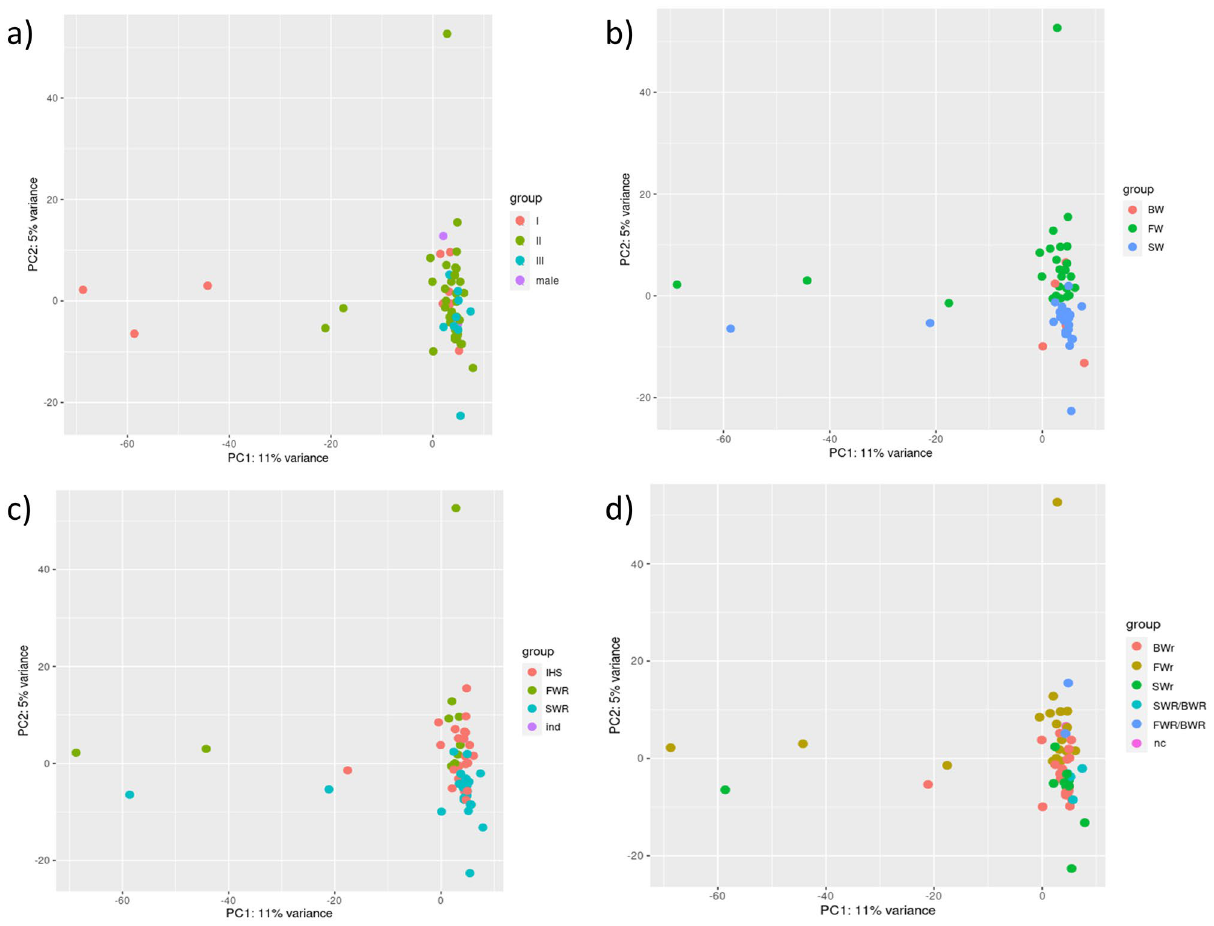
Figure 2. Principal component analysis (PCA) of the samples based on log2transformed transcriptomic values labelled based on their sex, that is silvering stage for female (I, II, III) and male ( a ), sampling site ( b ), otolith- based history ( c ) and fatty-acid based history ( d